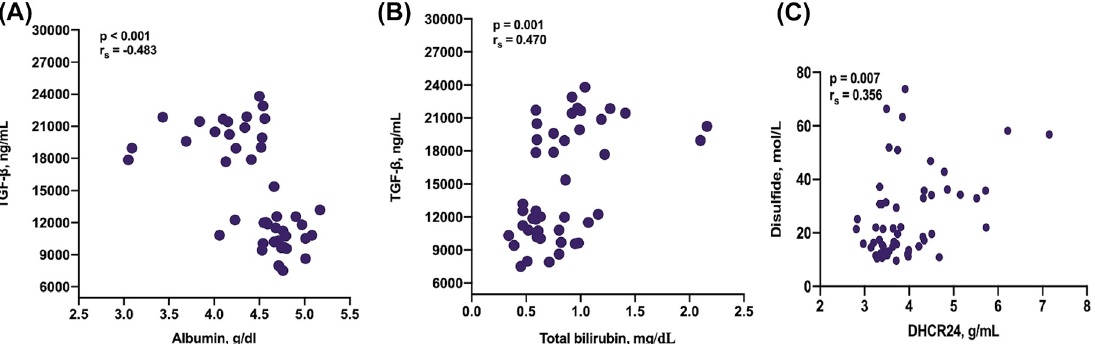
Figure 3: Correlation coefficients and p values (in parentheses) of the Spearman rank correlations between different variables. (A) TGF- β and albumin, (B) TGF- β and total bilirubin, (C) DHRC24 and disulfide. TGF- β , transforming growth factor-beta; DHRC24, 3 β -hydroxysterol Δ